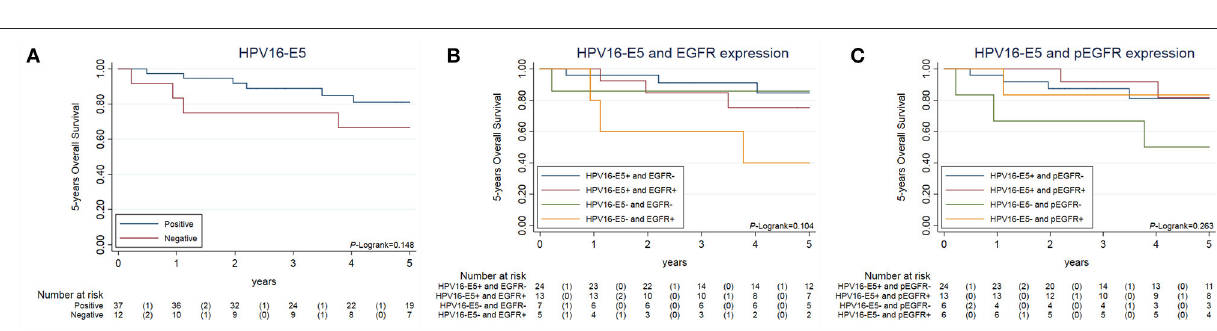
FIGURE 4 | Overall survival and disease free survival of of locally-advance OPC patients stratified by combination of HPV16 status and EGFR or pEGFR. Legend: Data on 5 years Overall Survival (A,B) and 5 years disease free survival (C,D) according to the combination of HPV16 status and EGFR or pEGFR. (A,C) Show OS and DFS Kaplan-Meier curve according to HPV16 status and EGFR expression. (B,D) Show OS and DFS Kaplan-Meier curve according to HPV16 status and pEGFR expression. The H0 assumed that all groups have equal OS and DFS.